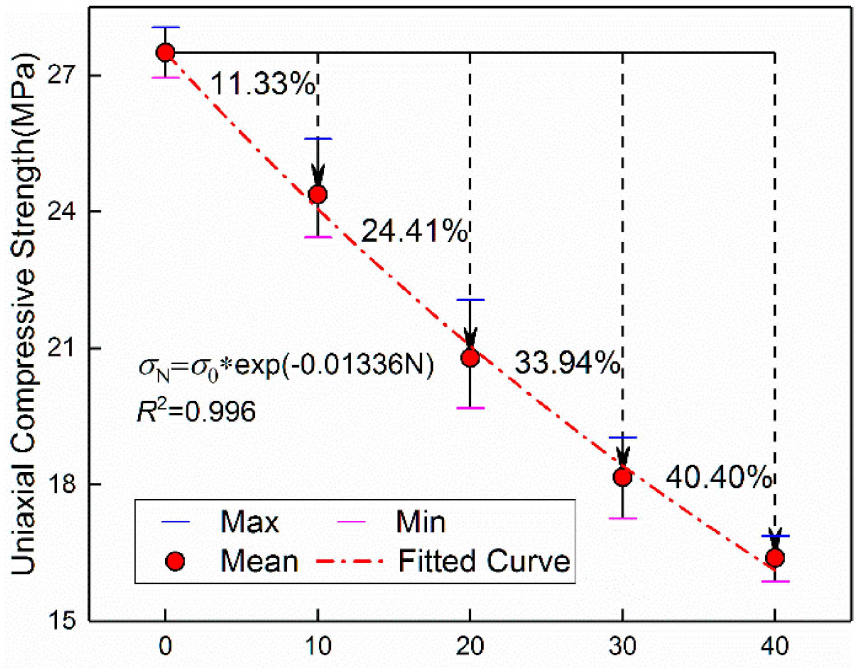
Figure 7. UCS and its reduction ratio for sandstone specimens after undergoing different quantities of F&T weathering